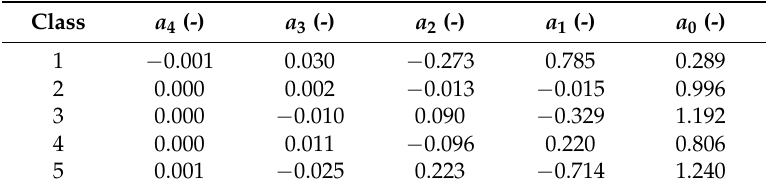
Table 2. Coefficients of the 4th degree polynomial reference profile for each class.